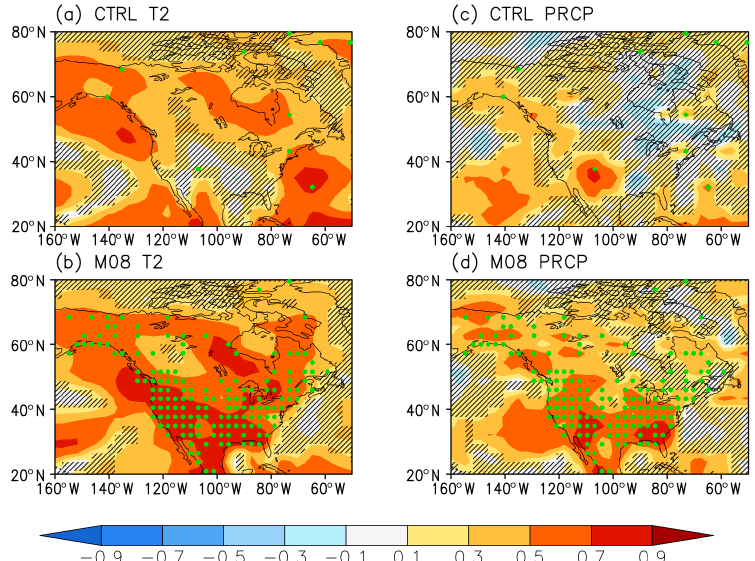
Figure 9. Temporal correlations in North America between the analysis and the truth for (a, b) temperature, and (c, d) precipitation, for experiments using different proxy networks. The green dots represent the location of the proxy sampling site. The hatched areas indicate where the correlation is not statistically significant ( p > 0 .